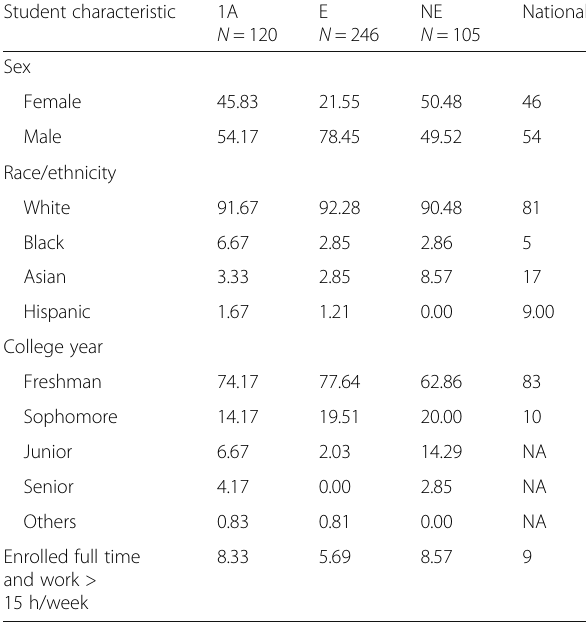
Table 3 Student demographics for Fall 2015 by percentages Student